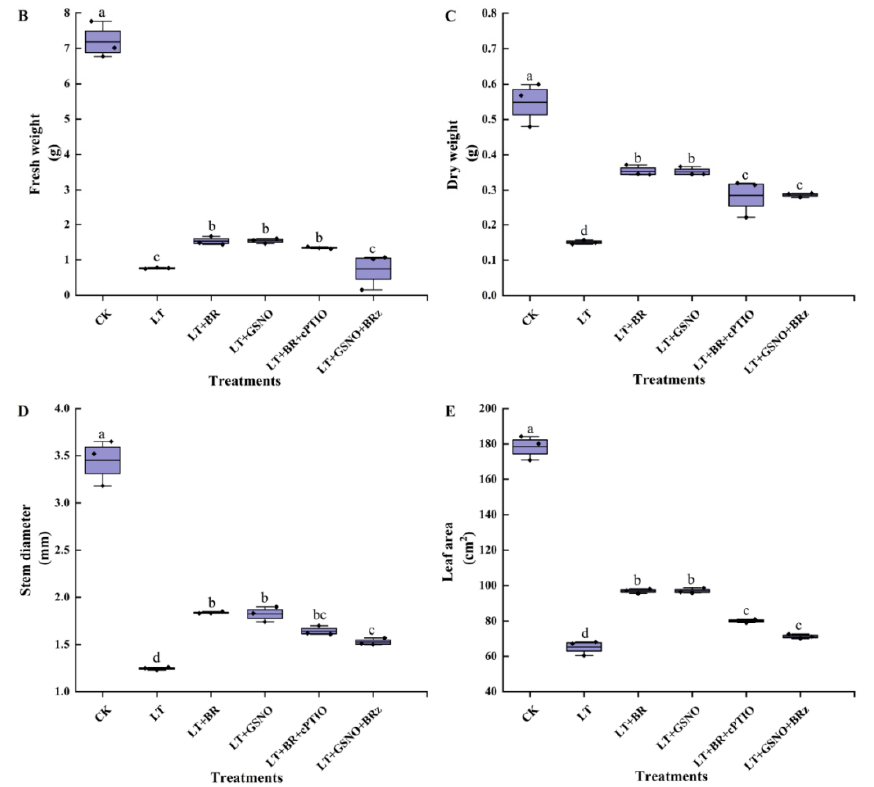
Figure 3. Effects of BR, GSNO, cPTIO and BRz treatments on fresh weight, dry weight, stem diameter and leaf area of mini Chinese cabbage under low temperature stress. Five-leaf seedlings were treated with CK (26/18 °C, day/night), LT (4/4 °C, day/night), LT + 0.05 mg/L BR, LT + 50 µM GSNO, LT + 0.05 mg/L BR + 50 µM cPTIO and LT + 50 µM GSNO + 10 µM BRz, cPTIO and BRz were sprayed separately, and then BR and NO were sprayed after an interval of 5 h, once every day for 3 d and treated for 7 days. After treating for 7 d, fresh weight, dry weight, stem diameter and leaf area were measured, respectively. ( A ) Phenotype and leaf size of the third leaf from outside to inside after treating for 7 d; ( B ) Fresh weight; ( C ) Dry weight; ( D ) Stem diameter; ( E ) Leaf area. Different lowercase letters above the error bars indicate significant differences at the 0.05 level ( p ≤ 0.05).